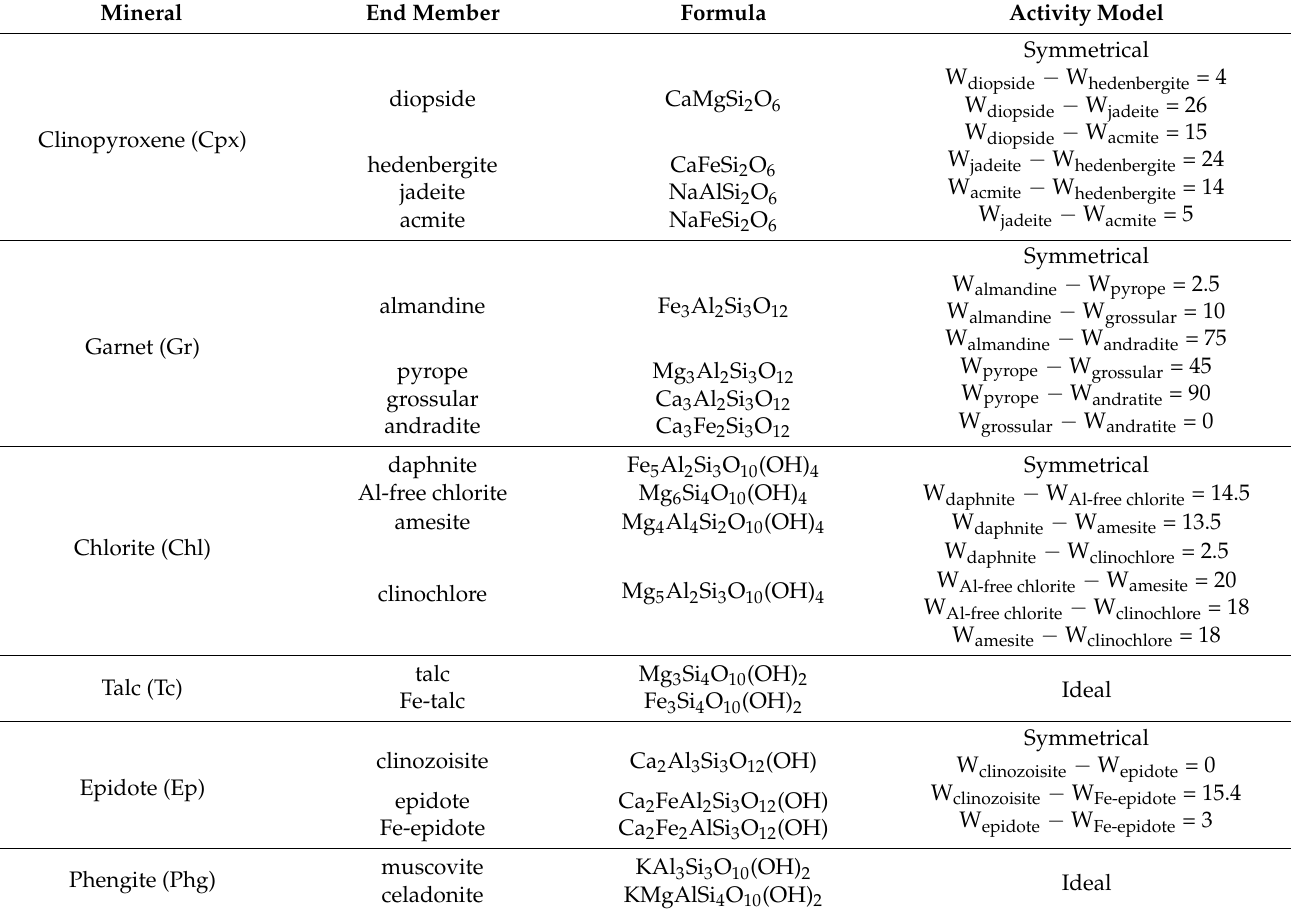
Table 4. Solid solutions involved in the modelling. The thermodynamic properties of end members are from Holland and Powell [33] and mixing parameters are from White et al.